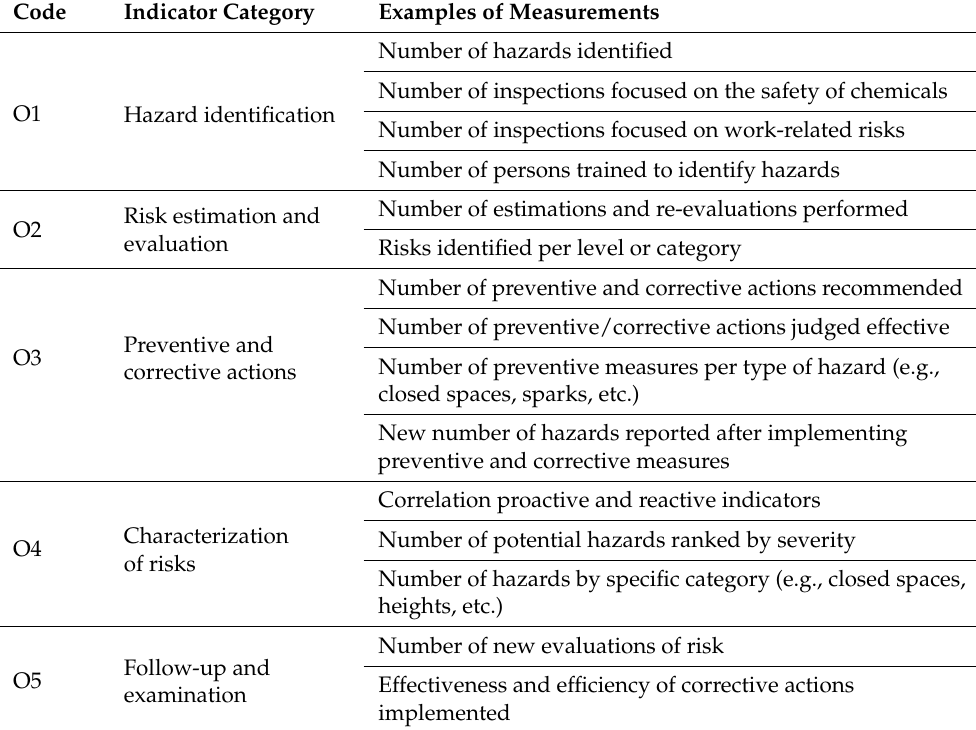
Table 15. Operations-based OHS indicators usable in small to medium-sized chemical companies [30].